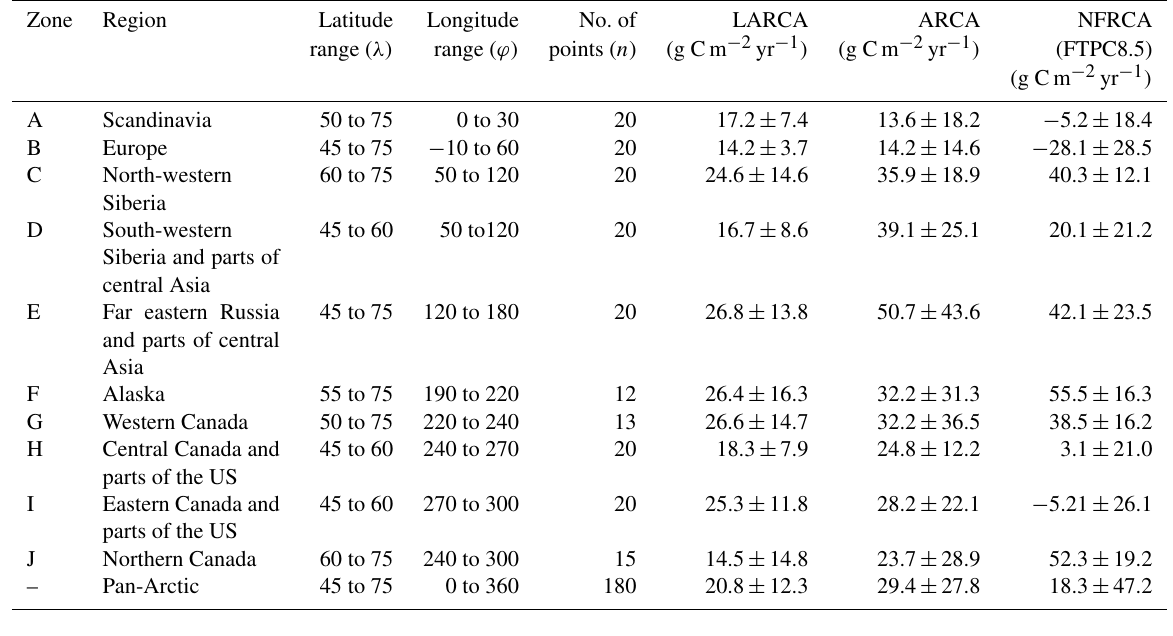
Table 1. Mean modelled C accumulation rates at different timescales in 10 geographical zones. Zone